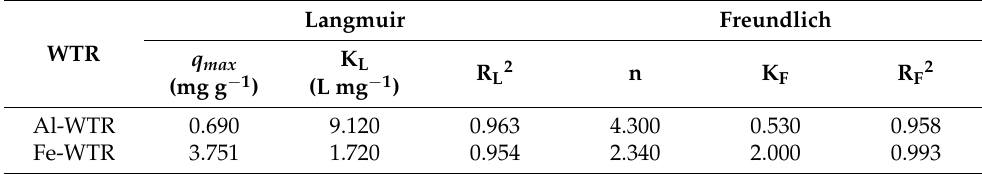
Table 3. Isothermal adsorption model parameters of Fe-WTR and Al-WTR for Tl(I).